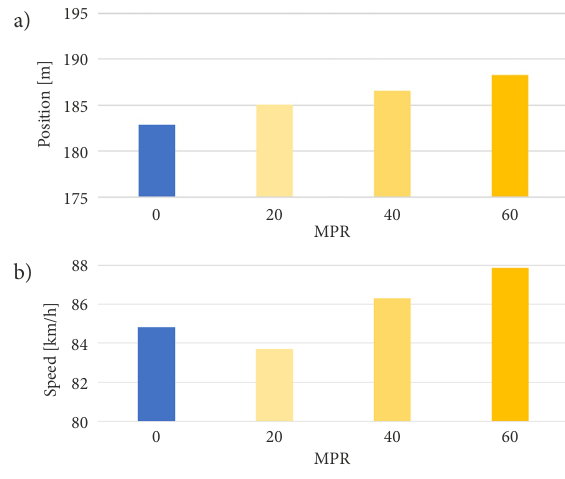
Figure 14. Merging position on the acceleration lane [m] (a) and average speed on the acceleration lane [km/h] (b) – dissolution strategy